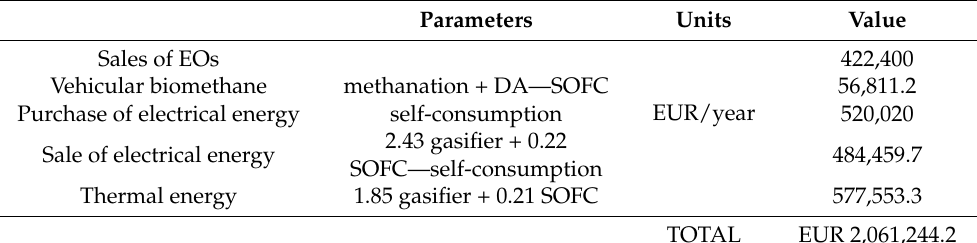
Table 12. Revenues associated with the proposed biorefinery